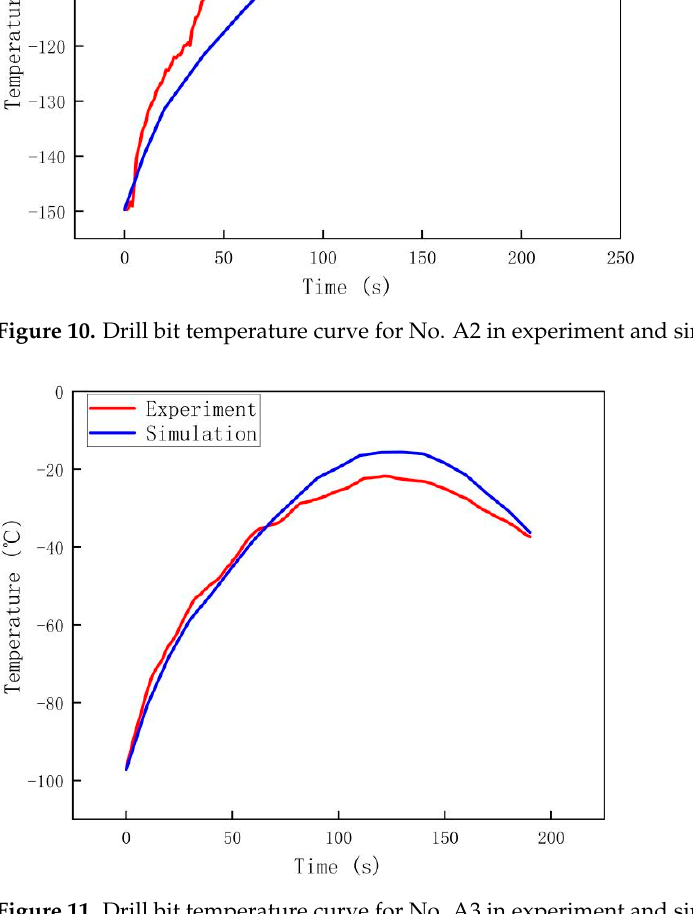
Figure 11. Drill bit temperature curve for No. A3 in experiment and simulation.